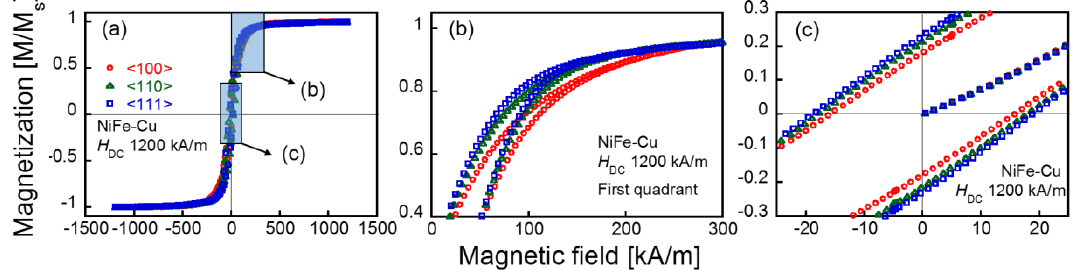
Figure 3. DC magnetization curves (major loop) of the NiFe-Cu nanocubes recorded with the maximal DC magnetic field, H DC, of 1200 kA/m ( a ), and their enlarged views ( b , c ). (( c ) includes the initial magnetization curves traced from the virgin state of the sample).